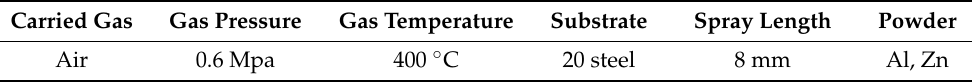
Table 1. Detail parameters of cold spray used in the experiment.